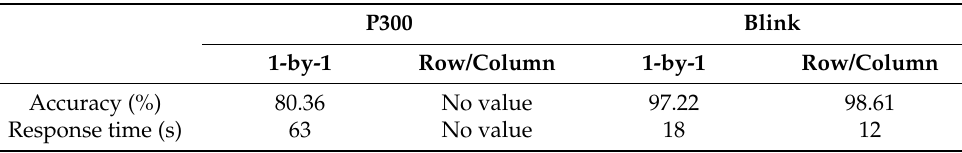
Table 4. Response time for both stimulation paradigms and control signals that provides an average accuracy higher than 80%. For the blink-based experiments, the minimum number of blinks are not taken into account due to their sensitivity to non-voluntary